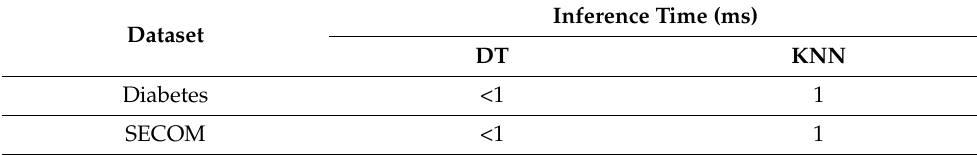
Table 8. Inference time performance on the edge device for the two supported